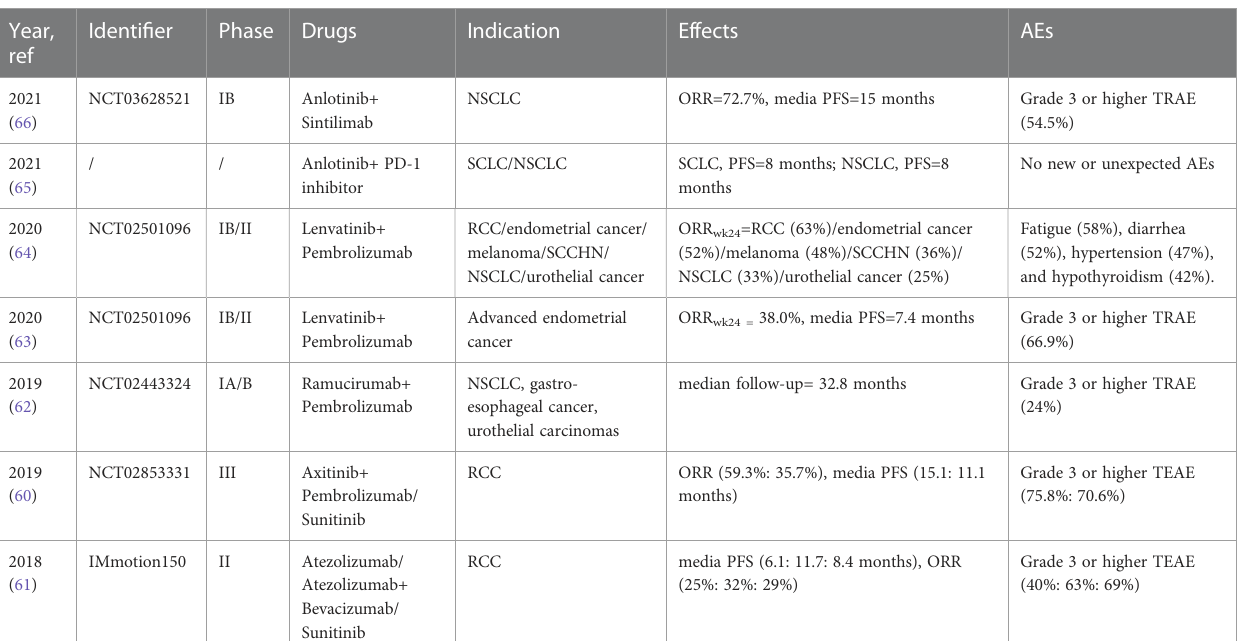
TABLE 2 Recent clinical studies involving the combined use of ICIs and antiangiogenic